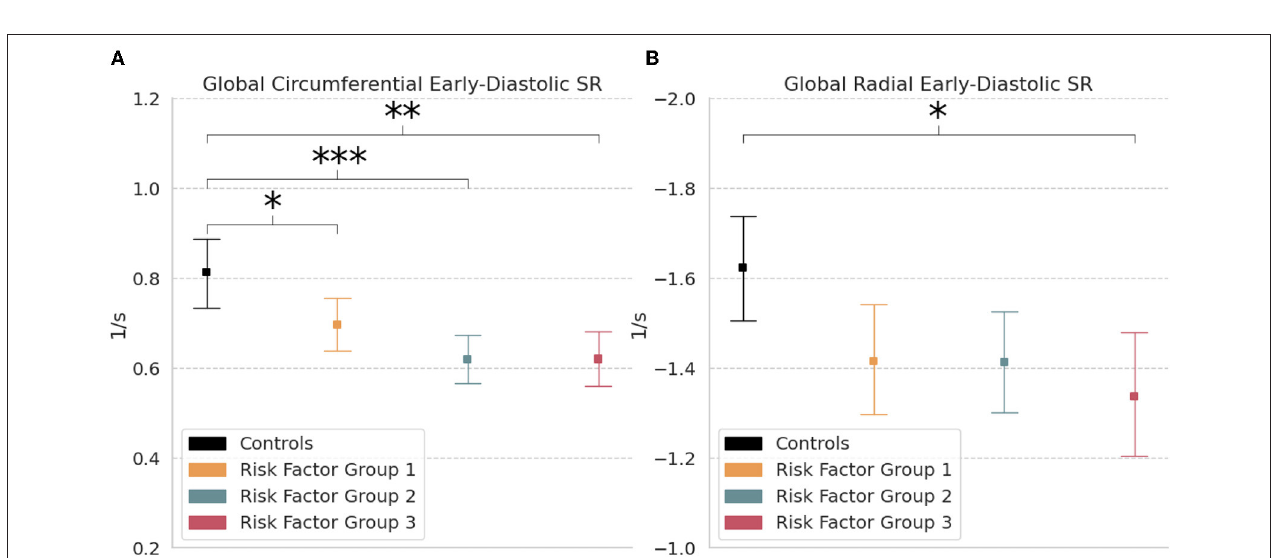
FIGURE 4 | Global strain rate. Measures of (A) Circumferential and (B) Radial early-diastolic strain rate (SR) in controls and risk factor groups. Strain results are visualized as mean with 95% confidence interval. post-hoc test by Bonferroni: * p < 0.05; ** p < 0.01; *** p < 0.001.